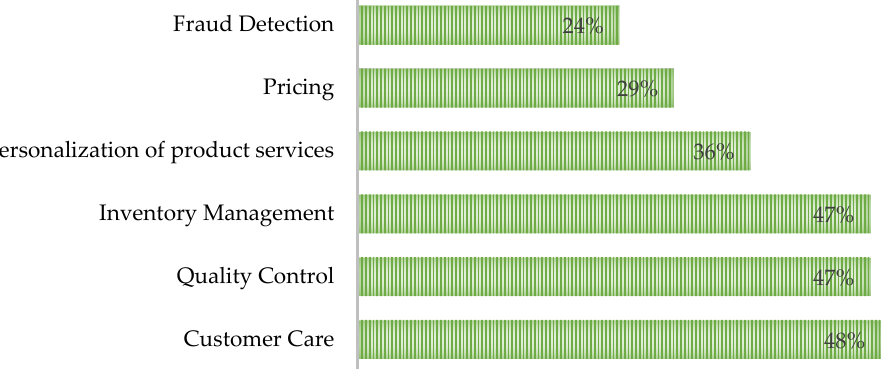
Figure 2. AI use cases in consumer goods and retail industry worldwide as of 2020. Data source: [29].